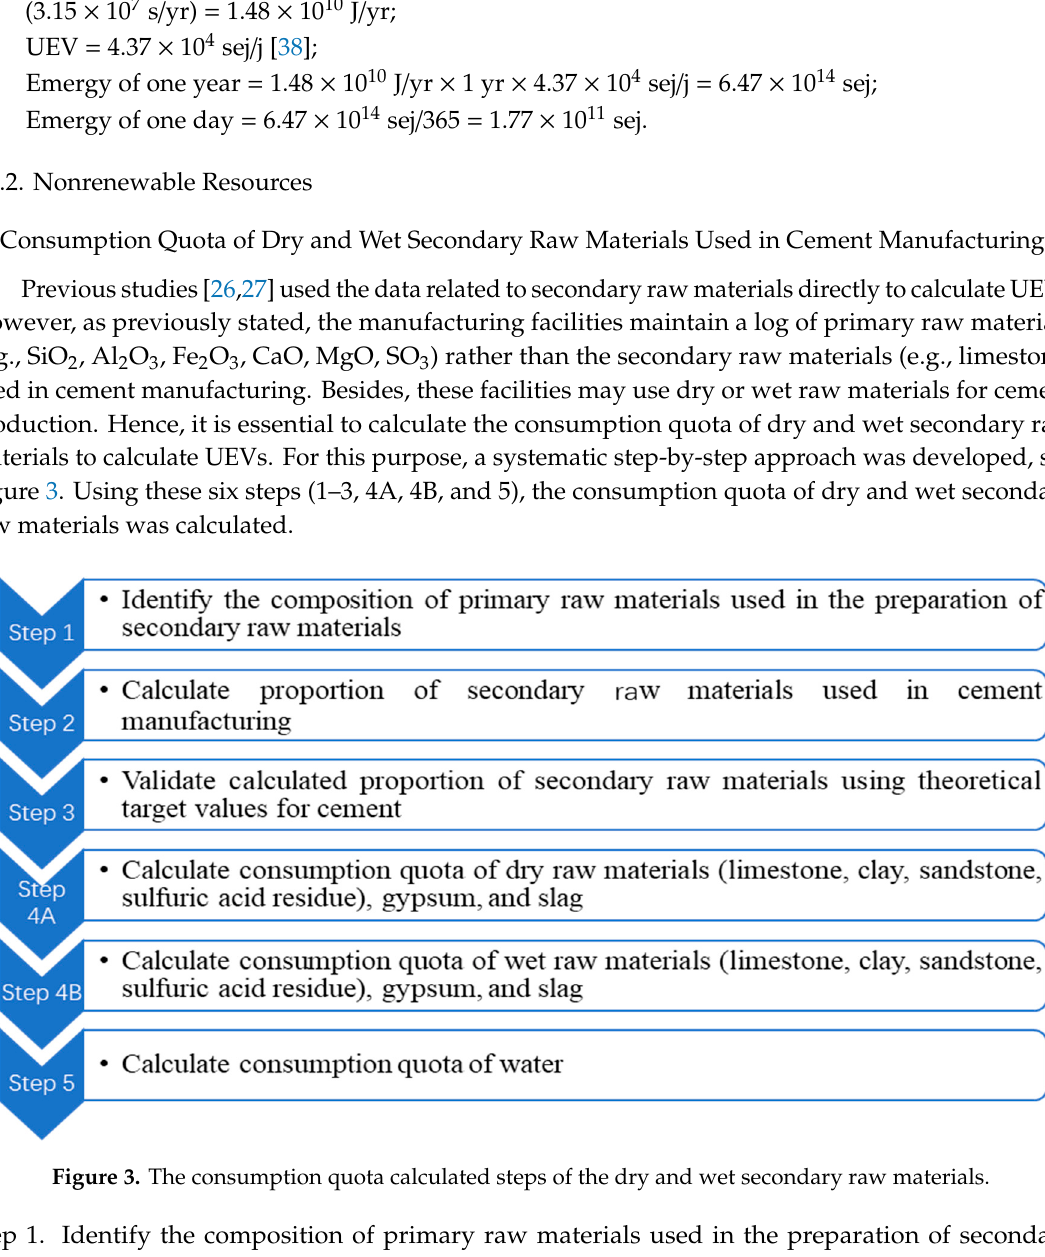
Table 3. Chemical composition of the secondary raw materials: limestone, clay, sandstone, sulfuric acid residue, and coal